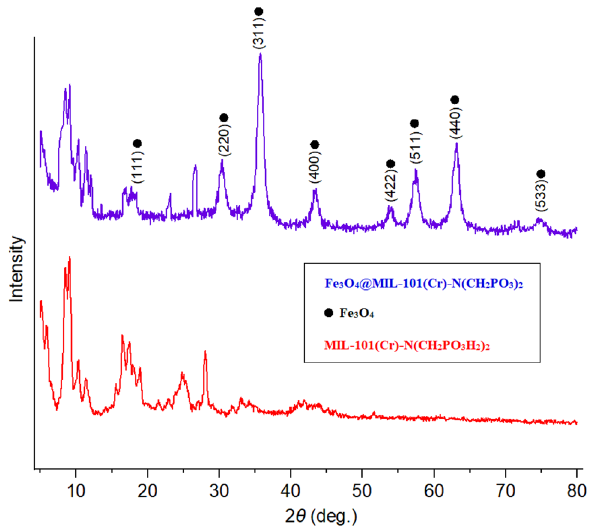
Figure 5. Comparison XRD pattern of catalyst and MIL-101(Cr)-N(CH 2 PO 3 H 2 ) 2 as starting material.